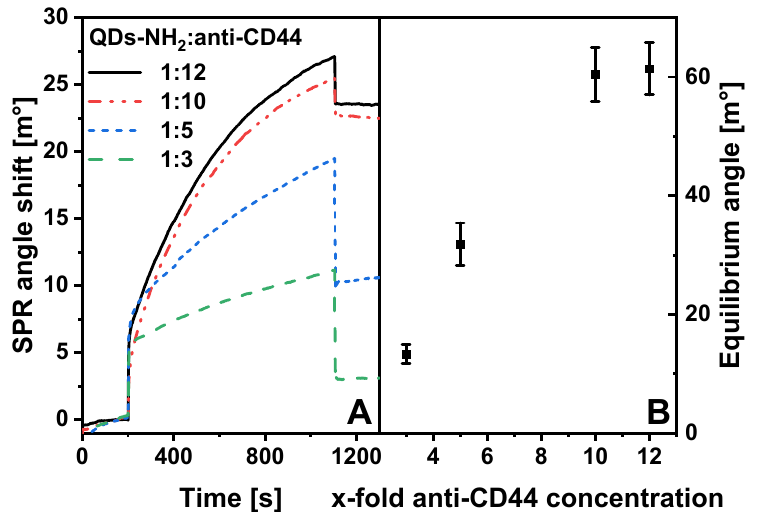
Figure 6. ( A ) SPR sensograms of the interaction of QDs-anti-CD44 conjugates prepared using QDs- NH 2 : anti-CD44 molar ratios of 1:3, 1:5, 1:10, and 1:12 with Au/CD44. ( B ) Dependence of the equilibrium angle on the x-fold concentration of anti-CD44.